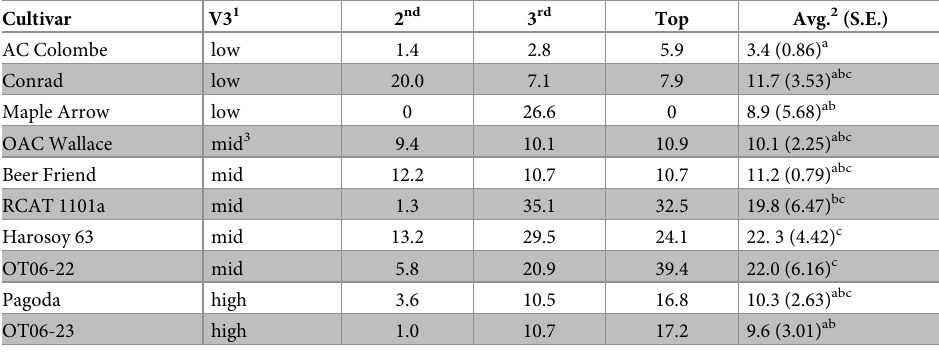
isoflavonoid levels at the V3 stage. Ten days after placing 5 TSSM larvae on the 3 rd leaf, the TSSM larvae/nymphs/adults as well as the eggs were counted on the 3 rd leaves (Fig 2A and 2B). The cultivars Maple Arrow, RCAT 1101a and Pagoda had the highest average TSSM counts, ranging from 10.0 to 22.3 on the 3 rd leaf, but these numbers were not significantly greater (Kruskal-Wallis; d.f. = 9; chi-sq. = 5.1385; P = 0.8221) than observed on the cultivars Table 1. Total isoflavonoid concentration ( μ g/g fresh weight) in control plants after the 10 day trial beginning at the V3 growth